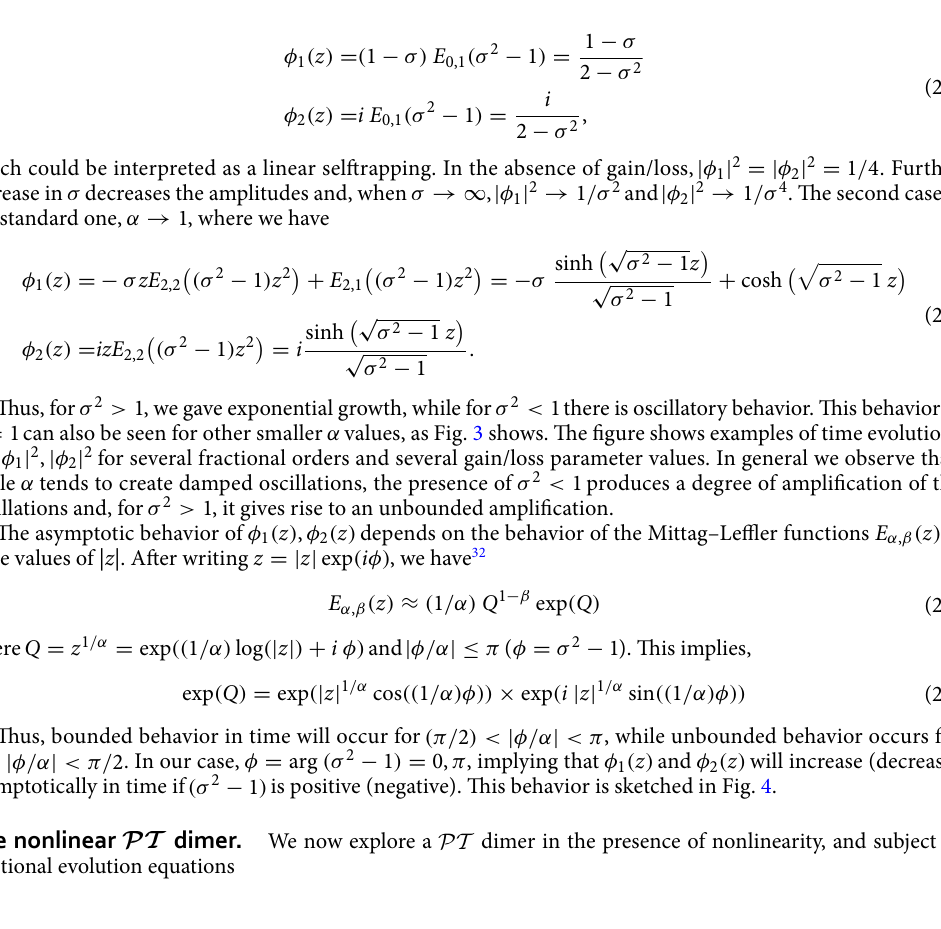
1, σ 0 , = = 0.9, σ 0.5 , ( g ) = =